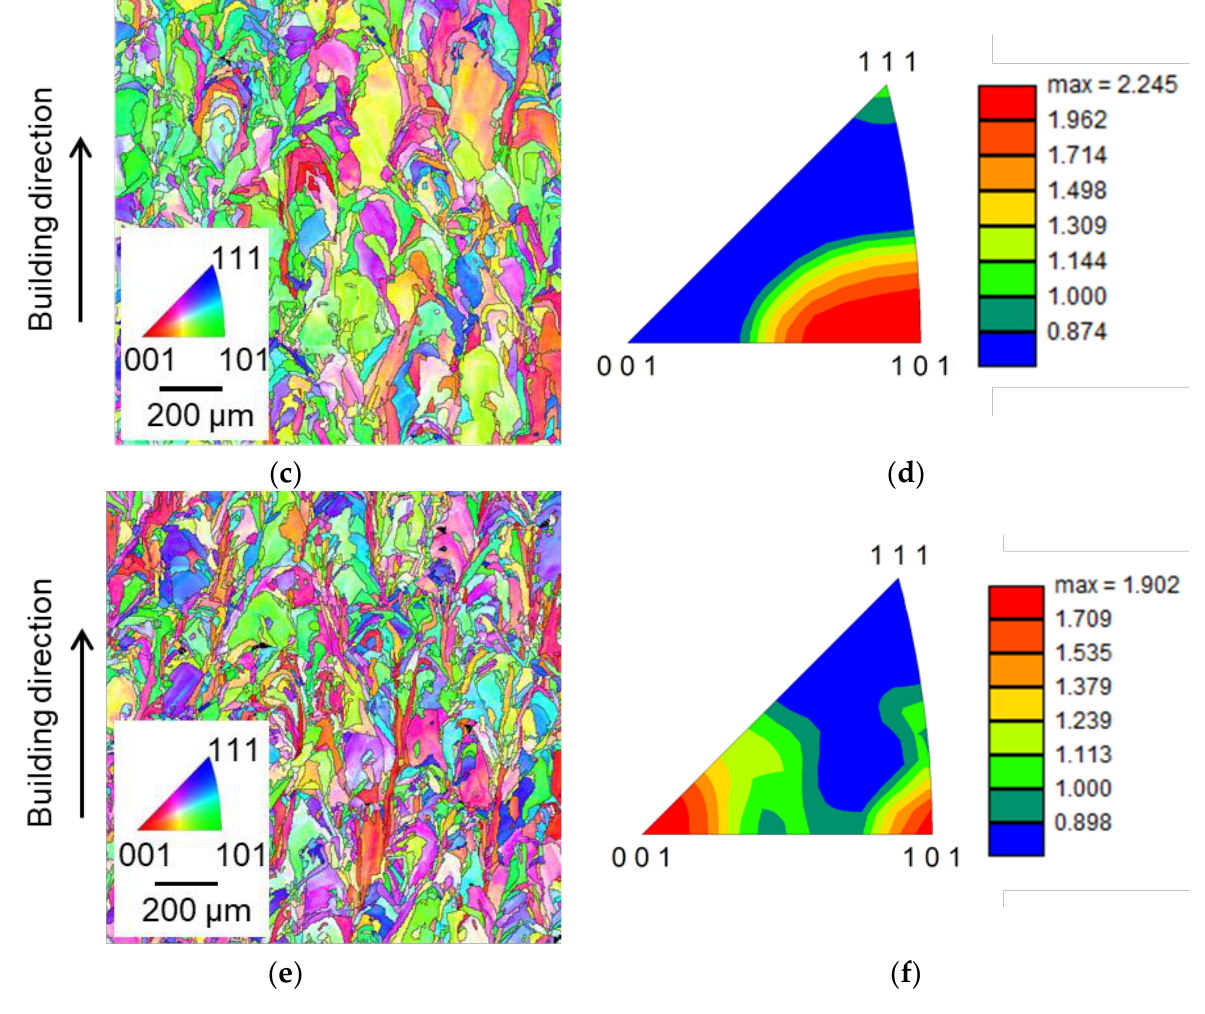
Figure 4. IPF images and corresponding crystallographic textures obtained using EBSD for the 0.6 m/s ( a , b ), 1.0 m/s ( c , d ), and 1.4 m/s ( e , f ) LBS conditions.